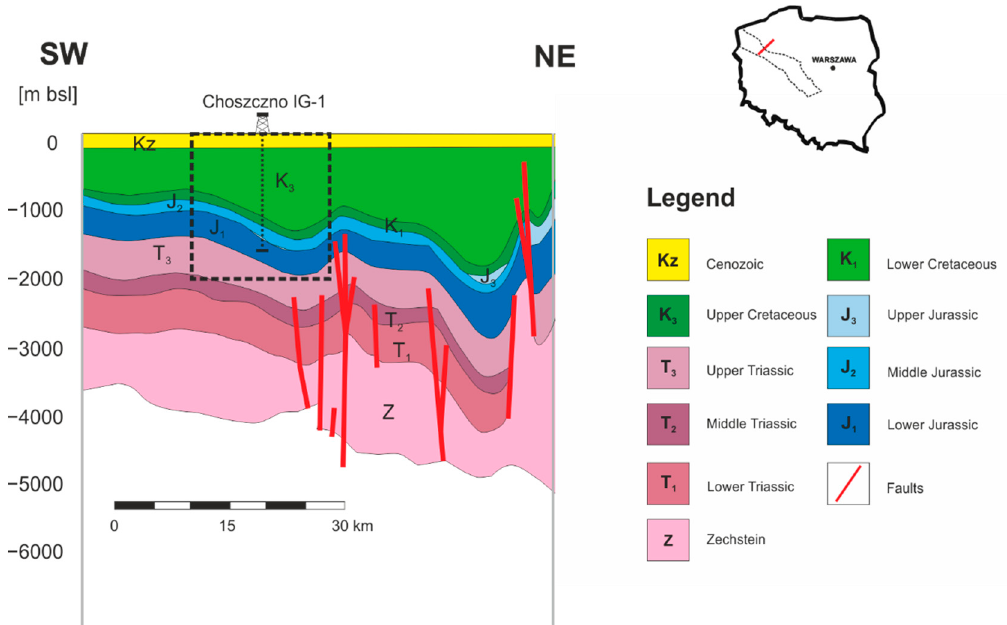
Figure 2. Geological cross-section through Szczecin Trough according to [36], modified. The black rectangle shows the range of the numerical model for which simulations of the geothermal doublet were carried out.